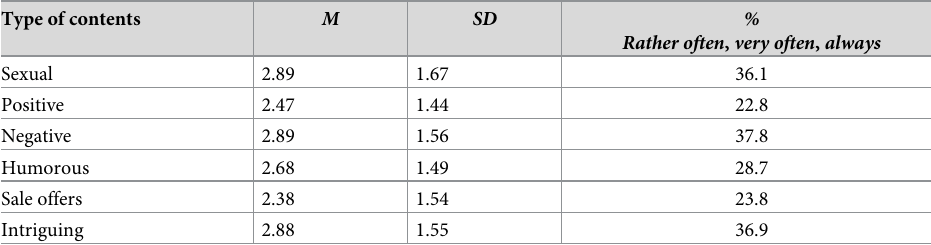
Table 2. Roadside advertisement content and the frequency of being distracted: descriptive